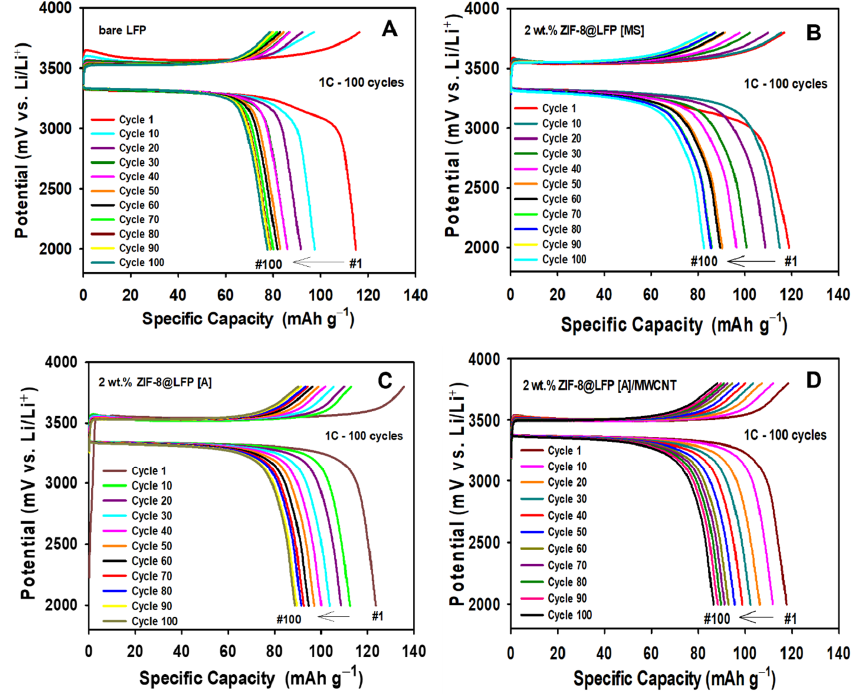
Figure 7. Charge–discharge curves of ( A ) bare LFP, ( B ) 2 wt.% ZIF-8@LFP [MS], ( C ) 2 wt.% ZIF-8@LFP [A], and ( D ) 2 wt.% ZIF-8@LFP [A]/MWCNT electrodes at 1C/1C rate for 100 cycles.